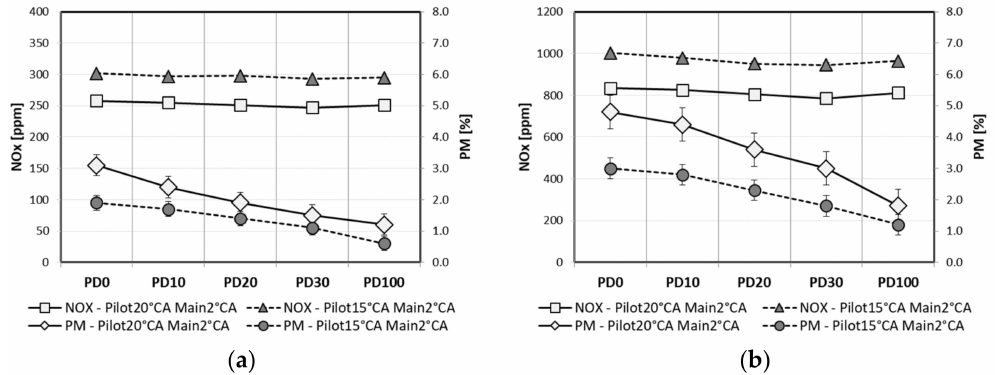
Figure 7. NO x and PM by engine loads: ( a ) engine load of 0 Nm and ( b ) engine load of 40